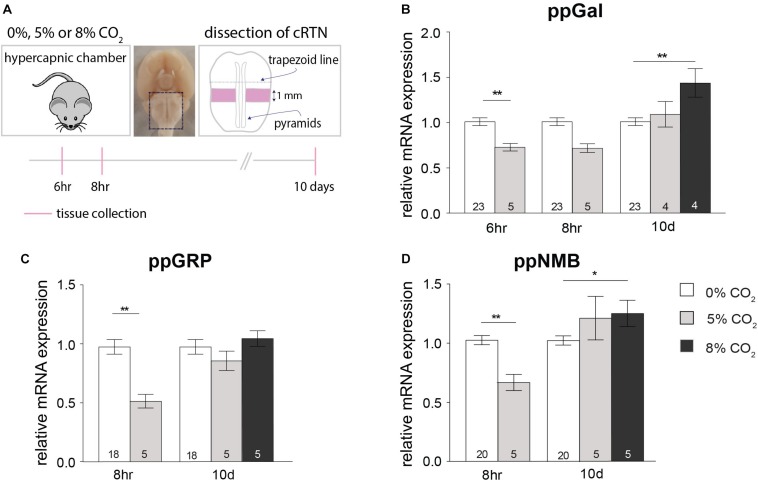
Short-term hypercapnia downregulates and long-term hypercapnia upregulates ppGal, ppGRP or ppNMB mRNA in caudal RTN (cRTN) measured by qPCR. (A) Strategy for hypercapnia exposure, tissue dissection and timeline for short-term hypercapnia and long-term hypercapnia paradigms. (B–D) ppGal, ppGRP and ppNMB mRNA expression levels following short-term (6 or 8 h) or long-term (10 days) elevated inspired CO2 (5% or 8%). The qPCR results were normalized to the expression levels of two house-keeping genes: HPRT and RPLPO. ∗p < 0.05, ∗∗p < 0.01 (One-Way ANOVA, Multiple comparisons: Dunnet).